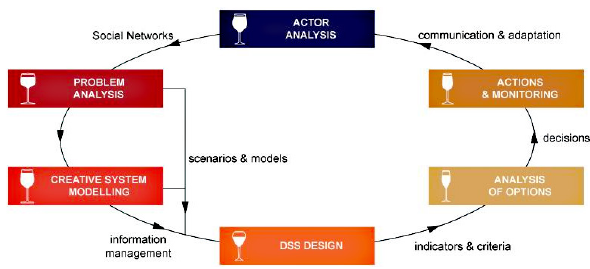
Figure 2. The NetSyMoD approach. The first 3 stages are utilsed in this approach.